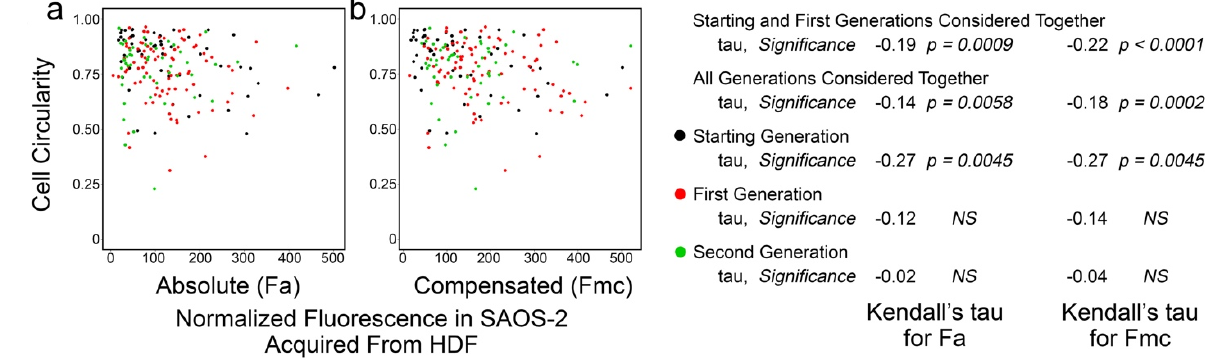
Figure 5. Scatter plots of experiment ‘a’ co-culturing SAOS-2 cells with HDFs, showing cell circularity of co-cultured SAOS-2 cells plotted against normalized fluorescence acquired from HDFs expressed as absolute fluorescence measured (Fa in panel a ), as well as with numerical compensation for halving of fluorescence by cell division from mother cells (Fmc in panel b ). The generation to which each cell belonged is indicated by the colour. Values for Kendall’s tau of correlation and their statistical significance are shown for individual generations of cells, starting and first generations together and all generations of cells together. ( a ) There was inverse correlation between cell-profile and Fa. ( b ) This was increased for